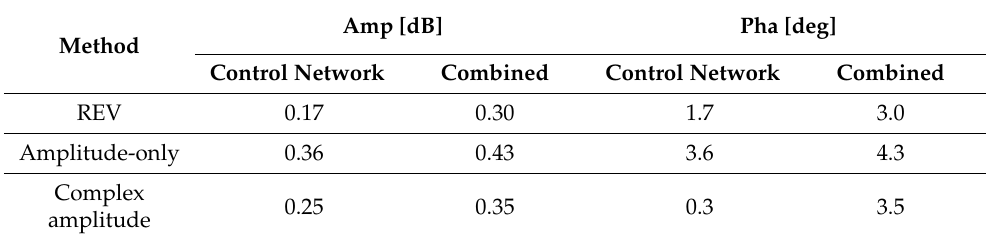
Table 2. The Comparison of The Standard Uncertainties of The Three Calibration